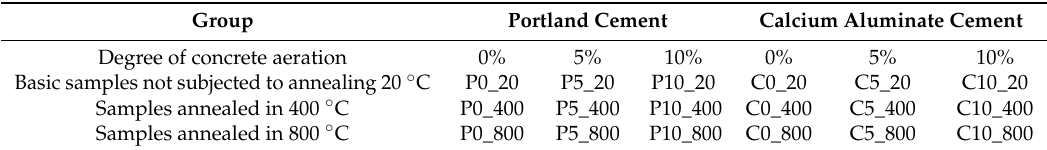
Table 2. Marking of samples used to